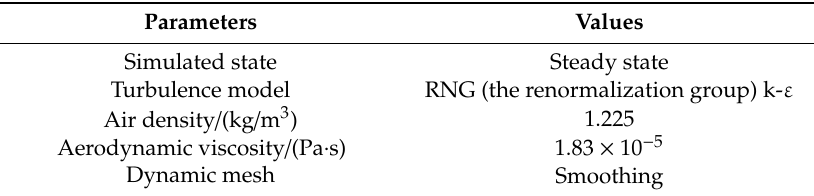
Table 4. Specific parameters of solver that were used in Fluent.